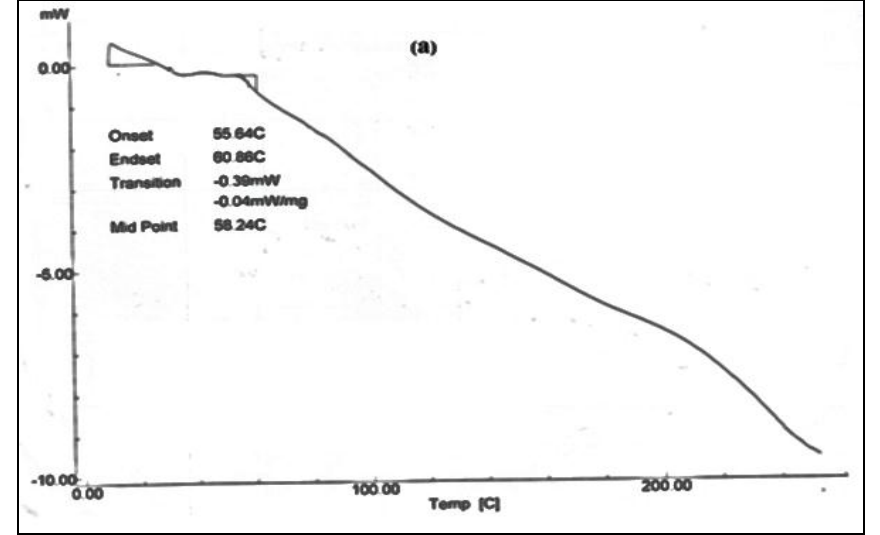
Fig.18: (Temperature glass transition) curves for UP/ nano SiO